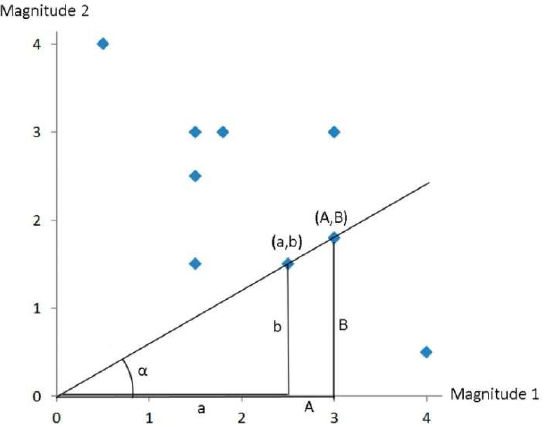
Figure 3. Graphical relationship between the tangent of an angle and the different points on the ray that starts from the origin of coordinates (tan( α ) can be written as b Consequently, given that two points ( a , b ) and ( A , B ) that share the same ray starting from the origin of coordinates always fulfill the expression b / a = B / A , in the case that a = 1, b = B/A . This fact shows that the ratio of Magnitude 2 over Magnitude 1 can be interpreted geometrically as the height of the cut-off point of the ray with the line of equation x = 1, as shown in Figure 4.